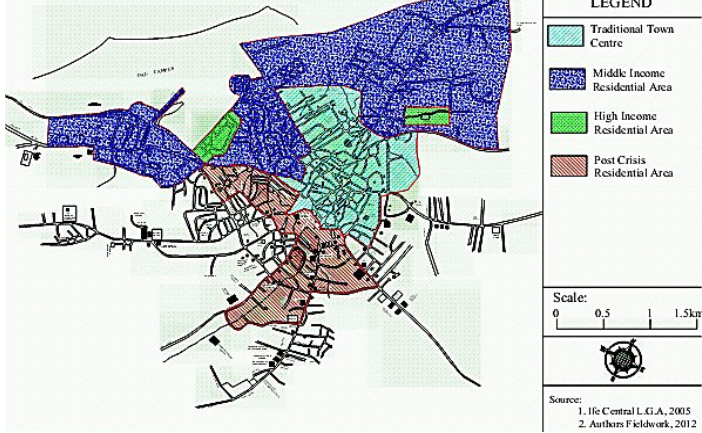
Figure 2. A map of Ile-Ife and its residential zones. Source: Ife Central Local